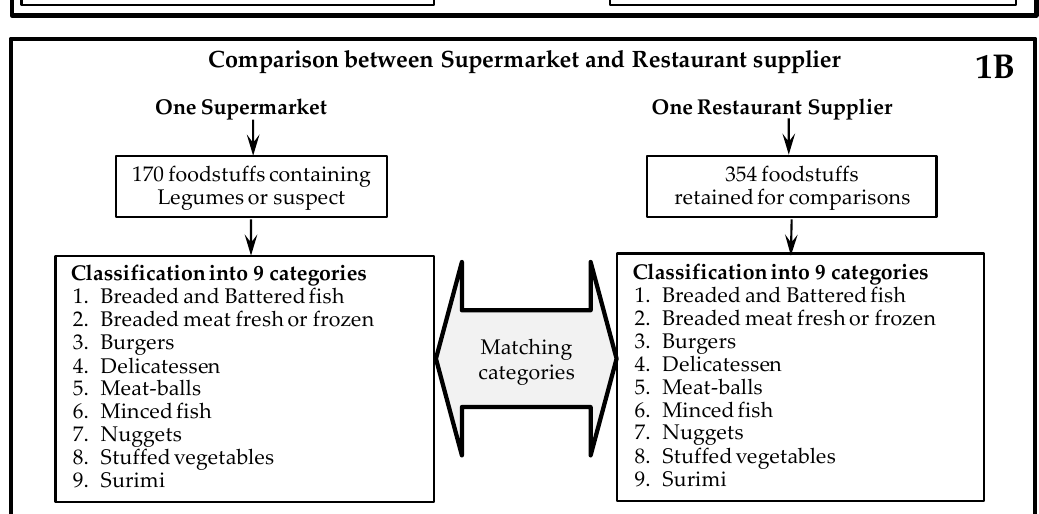
Figure 1. Diagrammatic representation of the food-item sorting considered in the different studies. 1A . Sorting applied to the global study of supermarkets and of the restaurant-supplier offerings. 1B . Sorting applied to the comparison between the two distribution circuits.